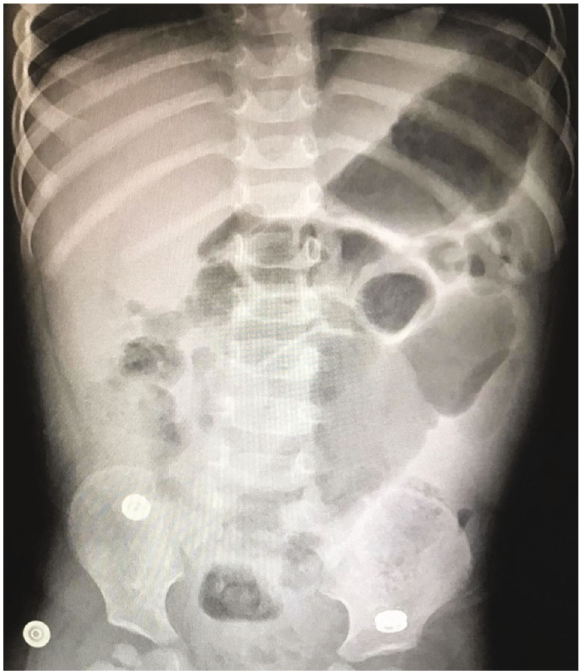
Figure 1: Preoperative abdominal X-ray shows foreign body ingestion though there was no suggestive